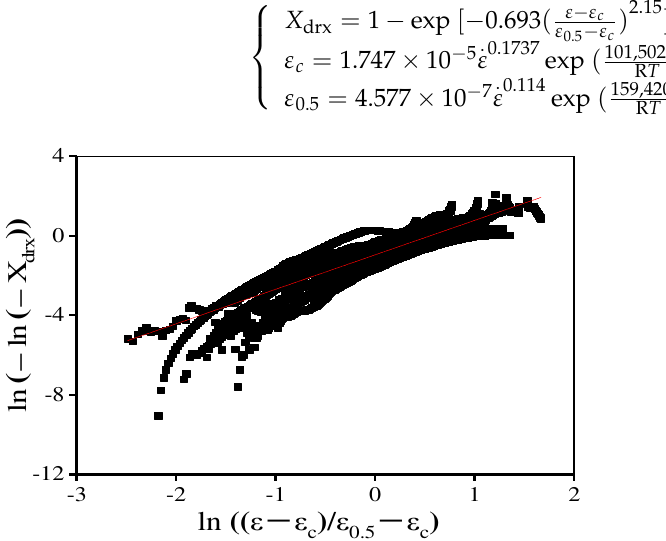
− ε c )) . ( − ln ( 1 − X )) and ln (( ε − ε c ) / ( ε 0.5 Figure 12. The relationship between Figure 12. The relationship between ln drx Figure 13 gives the relationship between the strain rate/ ε and the calculated X drx . Also, the comparisons between the calculated and experimental X drx are represented. To validate the precision of traditional DRX kinetics equations, the average absolute relative error (AARE) and correlation coefficient € are calculated,